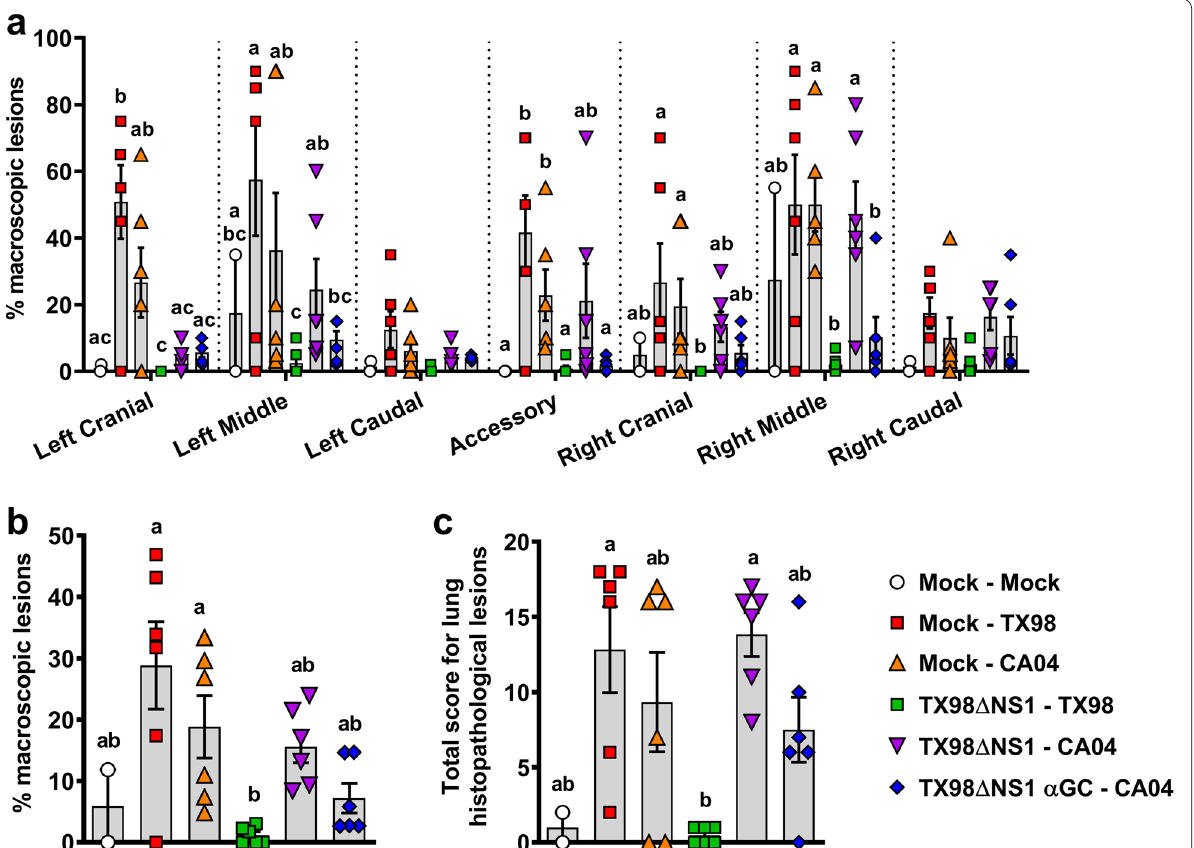
Fig 6 Macroscopic lung lesion scores and histopathology at 5 d.p.i.. a , b Macroscopic lesions assessed in ( a ) individual lung lobes and ( b ) total lungs according to the relative volume of each lobe. c Histopathology scores assessed by H&E staining according to the materials and methods. Differences between treatments were analyzed by Tukey’s ( a ) or Dunn’s ( b , c ) multiple comparisons test. A statistically significant difference between two groups is indicated by different letters. Data are represented as mean SEM. Symbols represent individual ±